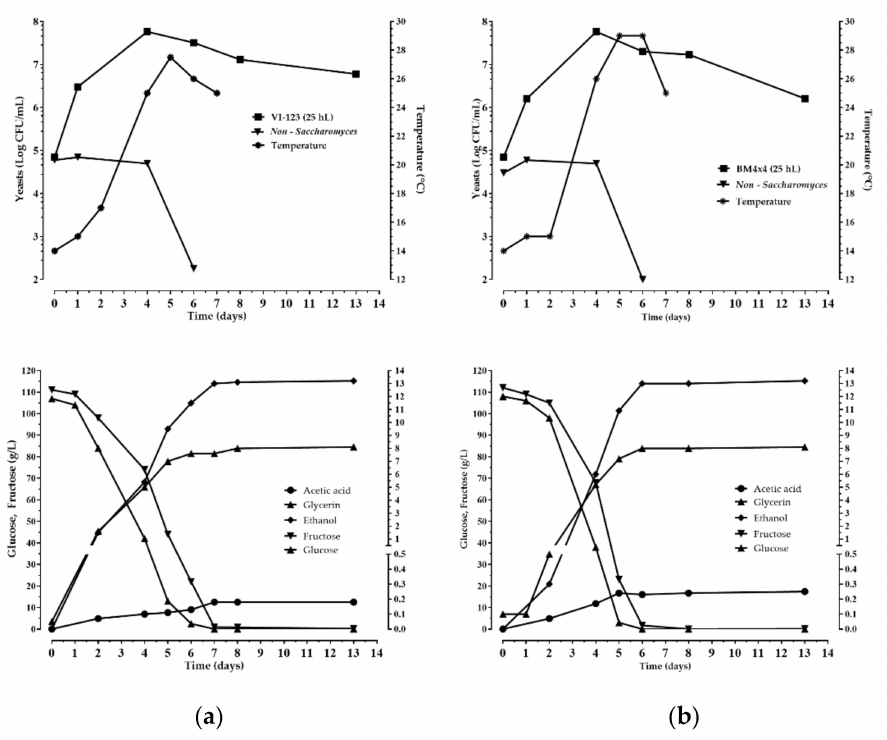
Figure 5. Chemical and microbiological monitoring of the wine fermentations obtained inoculating the indigenous S. cerevisiae strain VI-123 ( a ), produced using the plant, and the commercial starter BM4 × 4 ( b ) in 25 hL of grape